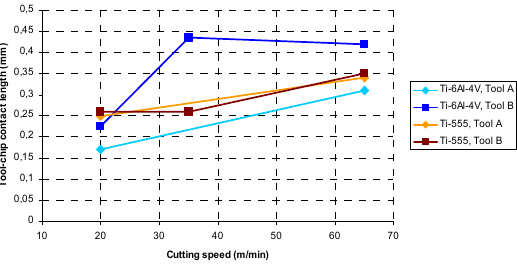
Figure 15. Evolution of the tool-chip worn contact length.